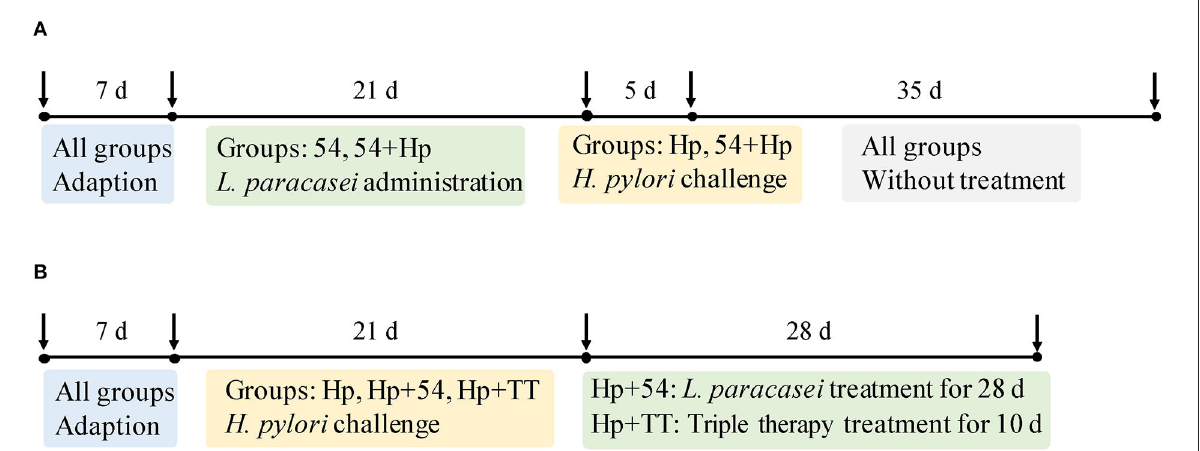
FIGURE1 Grouping of C57BL/6 mice for prevention and therapeutic models. (A) The preventive groups of control (normal mice without prevention and infection in the preventive group), Hp (mice infected with H. pylori without prevention in the preventive group), 54 (only treated with L. paracasei ZFM54), and 54 + Hp (pretreatment with L. paracasei ZFM54 before H. pylori challenge). (B) The therapeutic groups of control’ (normal mice without prevention and infection in the therapeutic group), Hp’ (mice infected with H. pylori without treatment in the therapeutic group), Hp + 54 (treatment with L. paracasei ZFM54 after H. pylori challenge), and Hp + TT (treatment with triple therapy after H. pylori